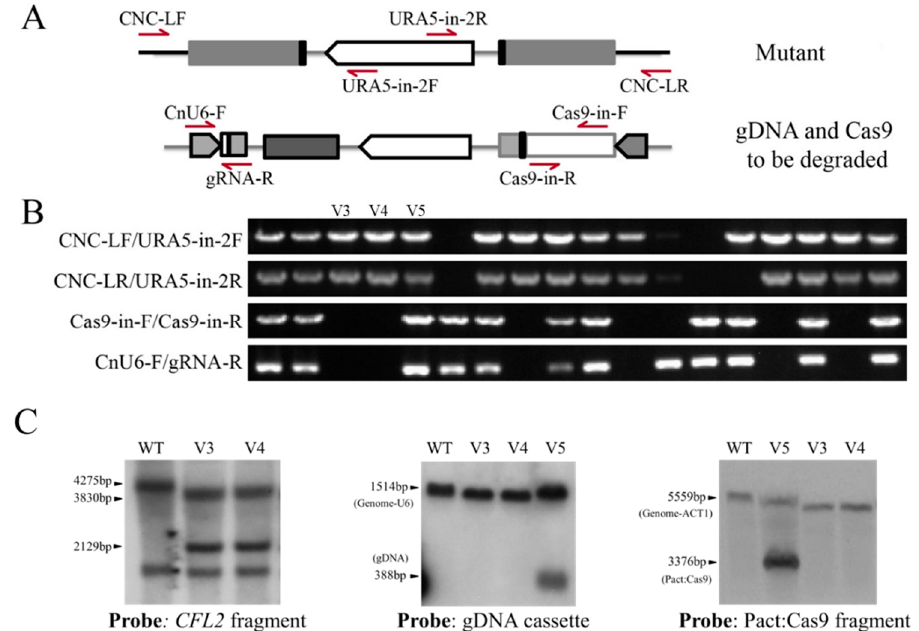
Figure 5. CFL2 disruption mediated by the simplified pRH003 system. ( A ) The locations of all primers used for PCR verification are indicated by arrows. ( B ) Confirmation of CFL2 disruption and CRISPR-Cas9 elimination by four rounds of PCR amplification in 18 transformants. The first and second rows confirm CFL2 disruption, the third row confirms the loss of Cas9, and the bottom row confirms the loss of gDNA. The results show that 6/18 transformants had a disrupted CFL2 gene, and both Cas9 and gDNA were eliminated. The specific primer pairs are indicated on the left side of the gel. ( C ) Southern blotting was conducted to confirm that CFL2 was disrupted and CRISPR-Cas9 cassettes were eliminated. The left panel shows the disruption of CFL2 , in which genomic DNA was digested with Hind III. The control 4500FOA had a wild-type CFL2 band (4275 bp), and the mutant strain had two bands (3830 bp and 2129 bp). The middle and the right panels show the loss of the gDNA and Cas9 cassettes in the V3 and V4